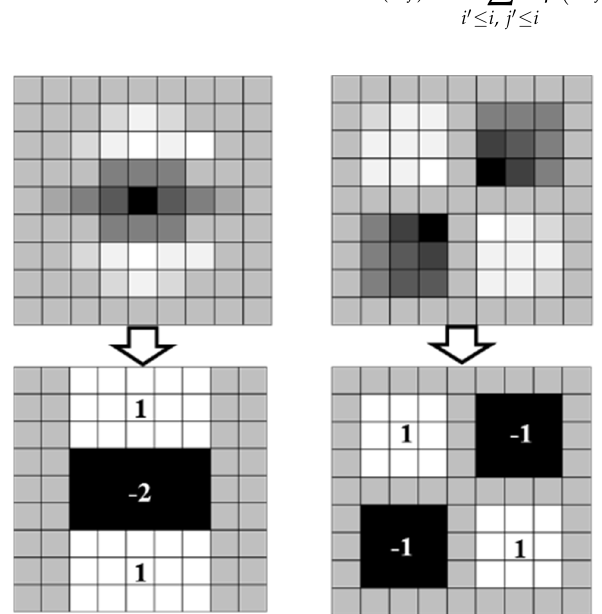
Figure 10. Gaussian filter to box filter.